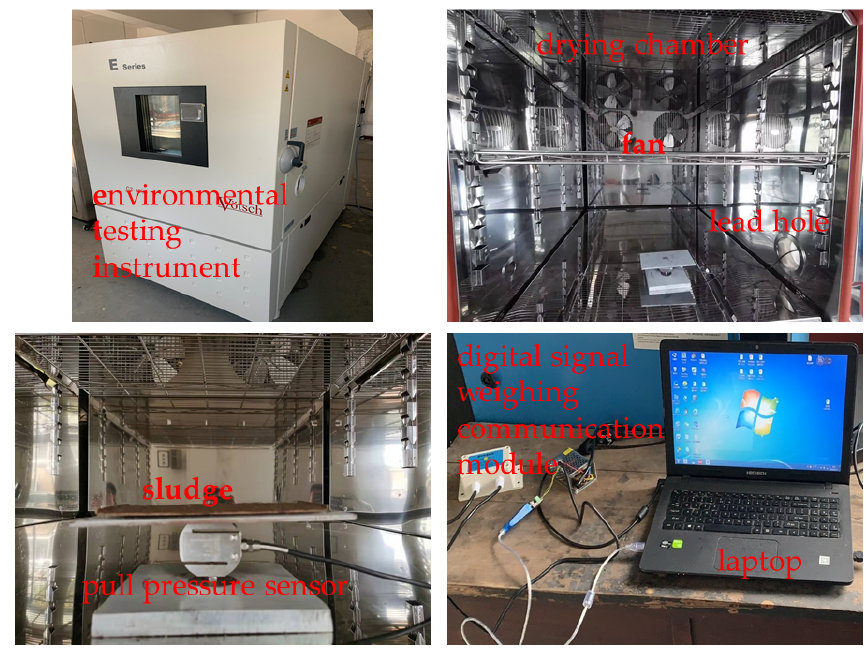
Figure 2. Pictures of experimental device.